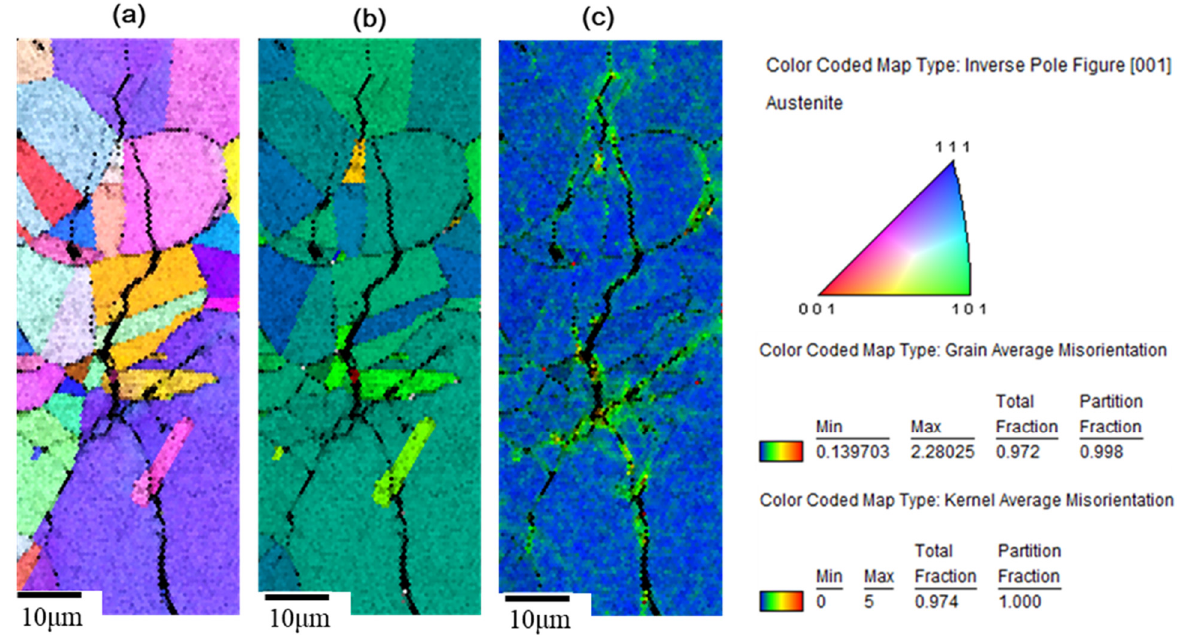
Figure 14. ( a ) Crystal orientation, ( b ) GAM, and ( c ) KAM maps by EBSD analysis of the specimen, as shown in Figure